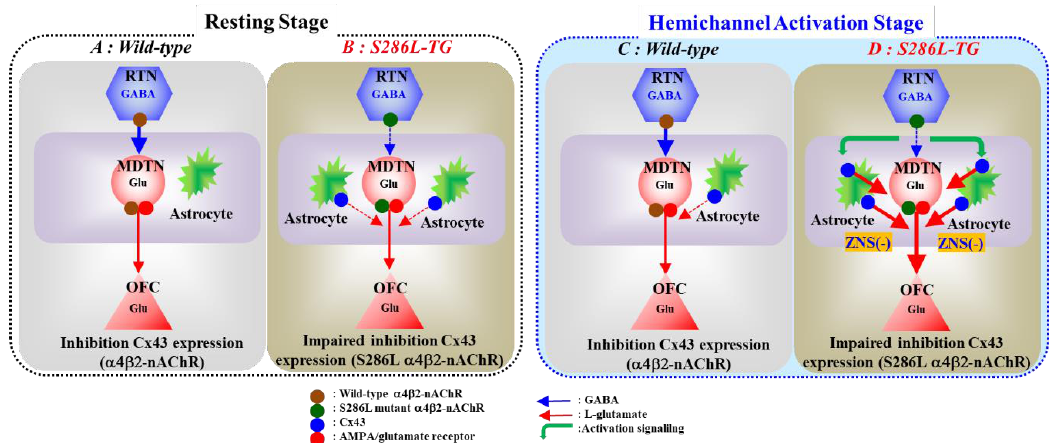
Figure 9. Proposed hypothesis of pathomechanisms and pathophysiology of S286L-TG. Proposed hypothesis for functional abnormalities of glutamatergic transmission in the thalamocortical pathways in wild-type (panel A ) and S286L-TG (panel B ) during the resting stage, as well as in wild-type (panel C ) and S286L-TG (panel D ) during the hemichannel activation stage. RTN mainly projects GABAergic terminals to MDTN. Activation of α4β2-nAChR in the RTN enhances GABAergic transmission in the RTN-MDTN pathways of wild-type (panel A ). MDTN project glutamatergic terminals to the OFC. In the MDTN, both α4β2-nAChR and AMPA/glutamate receptor activate glutamatergic transmission to the OFC (panel A ). Wild-type α4β2-nAChR suppresses Cx43 expression in astroglial plasma membrane in the thalamus (panel A ). Contrary to wild-type, in S286L-TG, loss-of-function S286L-mutant α4β2-nAChR attenuates the stimulatory and inhibitory effects on respective GABAergic transmission (RTN-MDTN) and Cx43 expression, resulting in upregulated Cx43 in the thalamus (panel B ). After the activation of hemichannel in the MDTN induced by calcium-free with high potassium stimulation, α 4 β 2-nAChR induced GABA release (RTN-MDTN) is not affected in both wild-type and S286L-TG (panels C , D ). Enhanced astroglial glutamatergic transmission associated with activated hemichannel in the MDTN leads to apparent impairment of GABAergic inhibition in wild-type, similar to S286L-TG during the resting stage (panel C ). In S286L-TG, propagation of neuronal excitabilities from the RTN to MDTN enhances thalamocortical glutamatergic transmission GABA A receptor independently via increased extracellular potassium and reduced extracellular calcium levels as hemichannel activation signalling (panel D ). A therapeutic-relevant concentration of ZNS chronically supresses Cx43 expression in the plasma membrane and acutely inhibits hemichannel activity (panel D ).